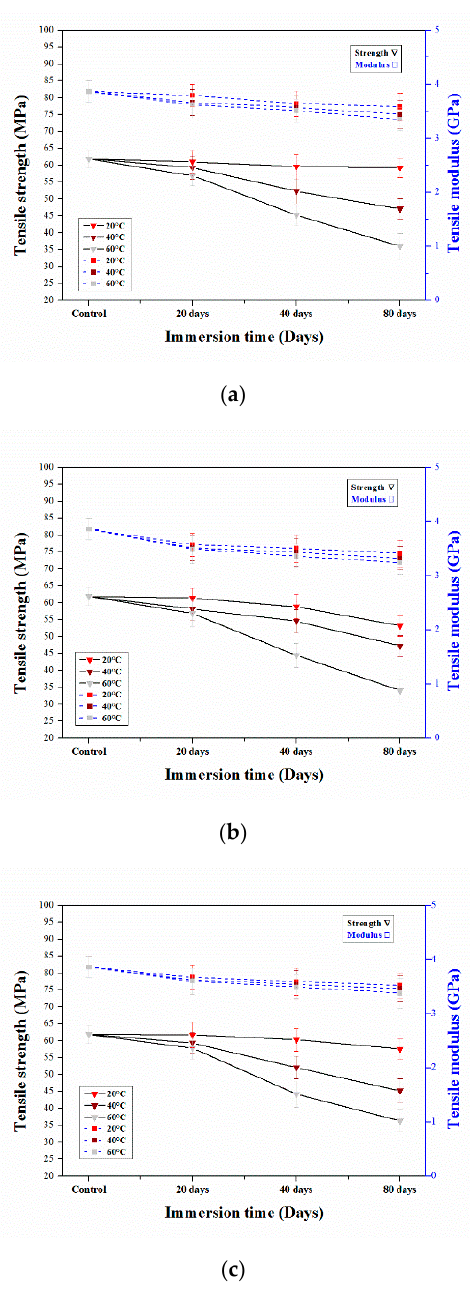
Figure 5. Tensile strength and modulus VS immersion days of neat epoxy resin in different immersion temperatures ( a ) Water ( b ) HCl and ( c ) NaOH solution.